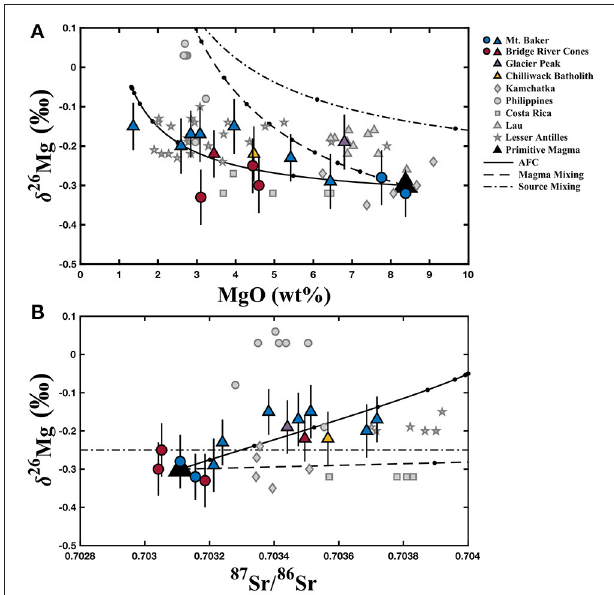
FIGURE 6 | AFC (assimilation-fractional crystallization) and bulk mixing models for δ 26 Mg vs. wt% MgO (A) and 87 Sr/ 86 Sr (B) for the North Cascades samples and available literature data. The colored circles represent those samples identified as most primitive from Mt. Baker and the Bridge River Cones, while the colored triangles represent samples that exhibit crustal contamination. The dashed and dotted line represents bulk mixing between depleted mantle and subducted sediment; the dashed line represents bulk mixing between primitive magma and subducted sediment; the solid line represents assimilation and fractional crystallization of lower continental crust by the primitive magma. Table 2 contains the end-member compositions, modeling parameters, and their sources. The black circles along the modeled curves represent 10% bulk mixing increments, and 10% crystallization increments in the AFC model. The black triangle represents the initial primitive magma end-member. Error bars represent the 2 SD for each North Cascades sample. North Cascades data are reported in Table 1 . Literature data (gray symbols) are from Li et al. (2017) and Teng et al. (2016).